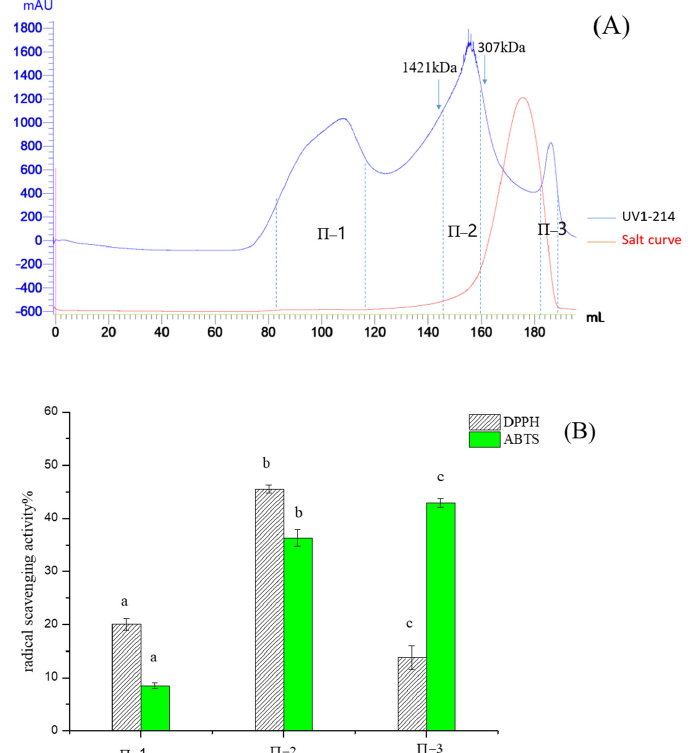
Figure 3. Elution profile of fraction II loaded on Sephadex G-25 column (1.6 × 90 cm) and activities of each fraction. ( A ) Chromatogram profiles of fraction II; ( B ) DPPH and ABTS radical scavenging activities of fraction II-1, fraction II-2 and fraction II-3. Different letters in the same test in ( B ) indicate significant differences ( p < 0.05). The reversed-phase column Pronto SIL C18 was used for further separation and pu- rification of Fraction II-2. As shown in Figure 4A, many antioxidant fractions eluted from the Pronto SIL C18 column, fraction 6 (named FII-2-6) exhibited the highest DPPH and ABTS radical scavenging values of 39.22% and 32.74% respectively, which was signifi- cantly higher than that of other 14 fractions ( p < 0.05) (Figure 4B). Therefore FII-2-6 was selected for further purification and analysis. The FII-2-6 was further purified by an ana- lytical column named Cosmosil pbr (Ø4.6 × 250 mm, 5 μ m), and the results are shown in Figure 4C. Nineteen chromatographic peaks were obtained, and all of them exhibited ac- tive values to a certain extent, of which peaks 3, 5, and 7 (named FII-2-6-3, FII-2-6-5, FII-2- 6-7) showed a higher active value of DPPH radical scavenging activities of 33.93%, 34.23% and 32.73%, respectively, and ABTS radical scavenging activities of 28.53%, 32.91 and 30.20% respectively (Figure 4D). The Xselect TM CSH130 (Ø4.6 × 250 mm, 3.5 μ m) column was selected for further separation of fractions of FII-2-6-3, FII-2-6-5 and FII-2-6-7, respec- tively. As shown in Figure 5A–C, each of these three components showed a single peak by secondary reverse phase, which was collected respectively for determining the amino acid sequences.